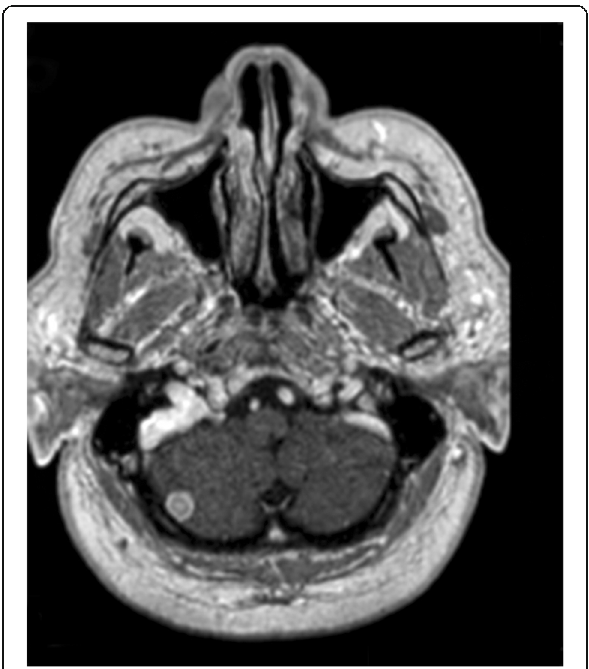
Fig. 2 Posterior fossa MR imaging: more caudal sections show contrast-enhanced lesion attached to the dura